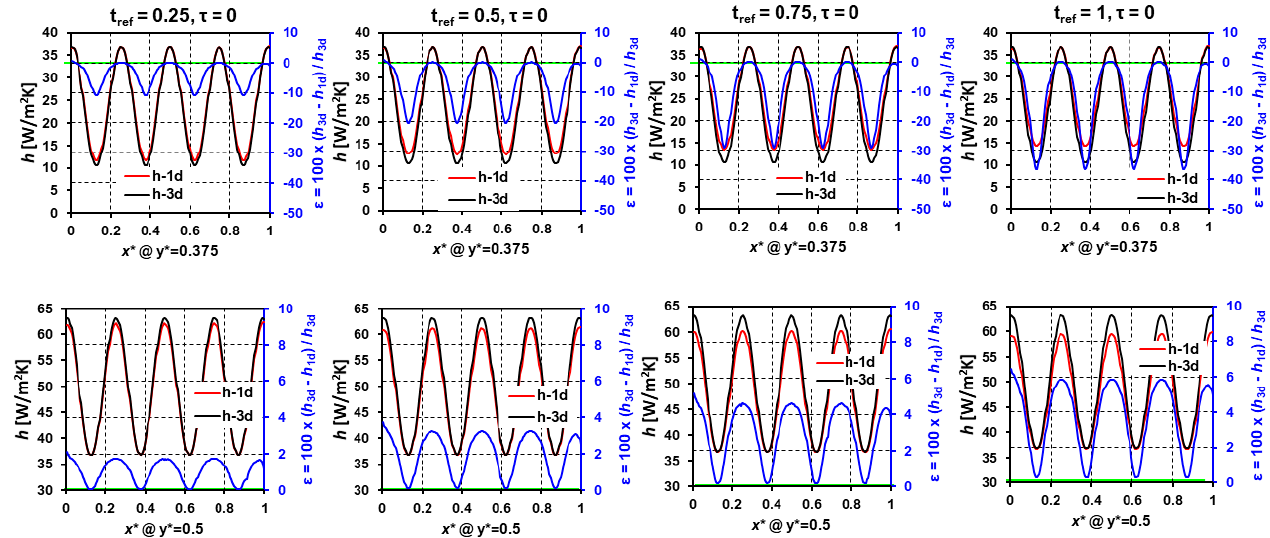
Figure 16. Method D, Case II: Local h variation at y* = 0.375 and y* = 0.5 and their relative % differ ‐ ences.